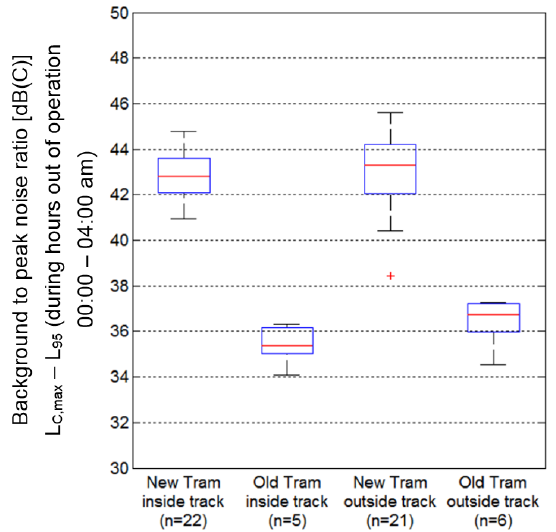
Figure 6. Background to peak noise ratio C ‐ weighted: tram comparison at measuring point 1.